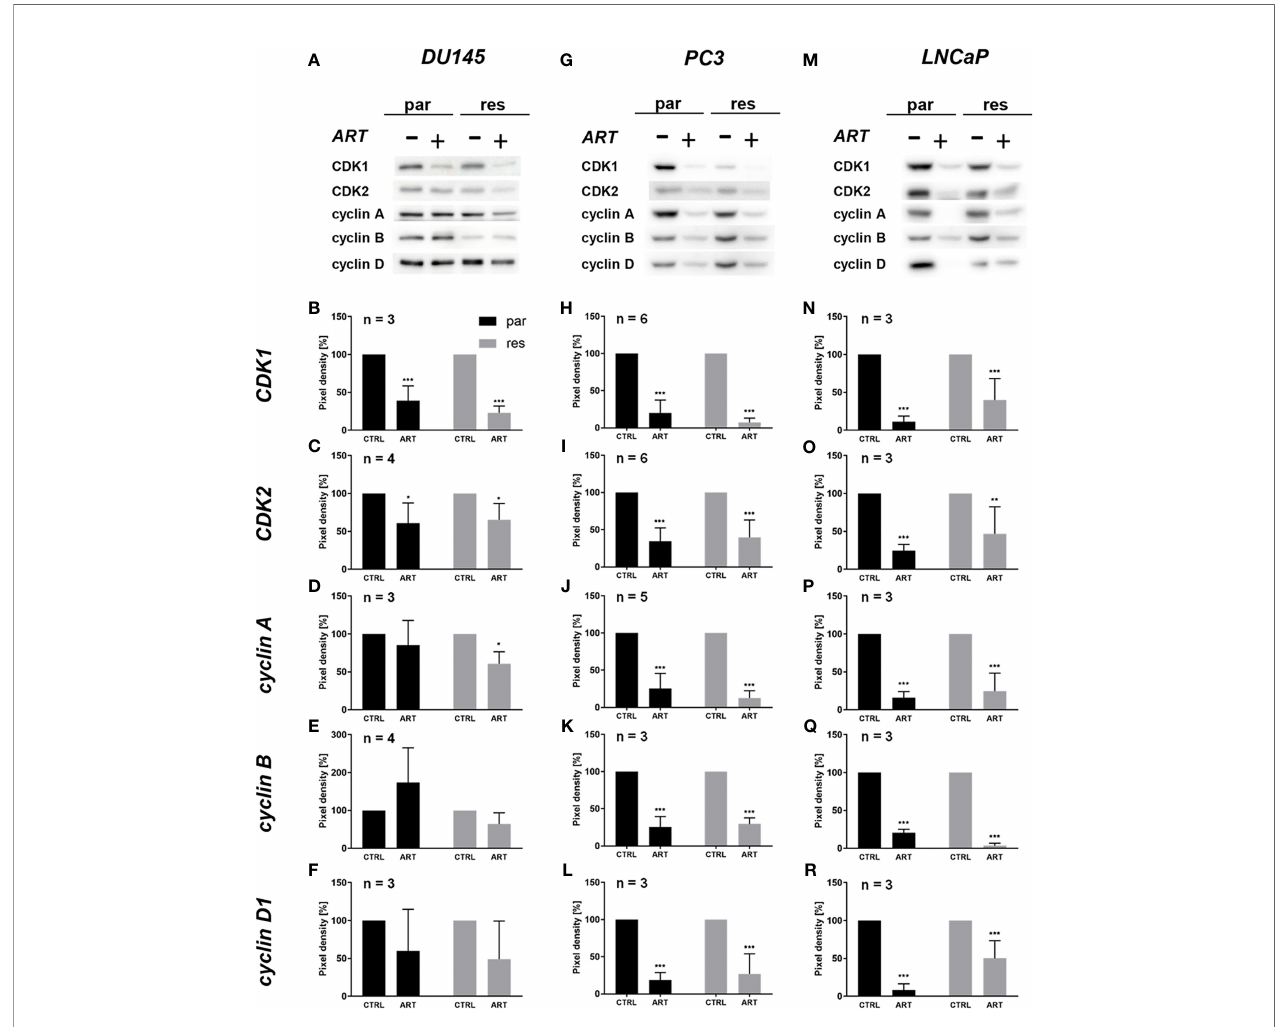
FIGURE 4 | Expression of cell cycle regulating proteins: representative Western blot images of cell cycle regulating proteins in parental (par) and DX-resistant (res) DU145 (A) , PC3 (G) , and LNCaP (M) cells with (+) and without (-) ART. Pixel density analysis of the expression of cell cycle regu-lating proteins CDK1 (B, H, N) , CDK2 (C, I, O) , cyclin A (D, J, P) , cyclin B (E, K, Q) and cyclin D1 (F, L, R) in parental (par) and DX-resistant (res) cells after 48 h exposure to ART [37.5 µM], compared to untreated controls (set to 100%). Analysis of pixel density was normalized by a total protein staining. Error bars indicate standard deviation (SD).